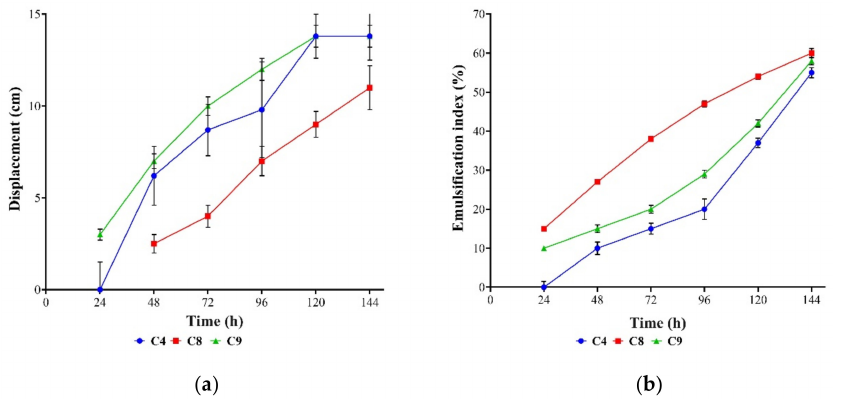
Figure 2. Biosurfactant production in BH media with olive oil (2% w / v ) as the carbon source. Displacement of olive oil ( a ) and emulsification index E24 ( b ). Data are given as the mean ± SD ( n = 3).